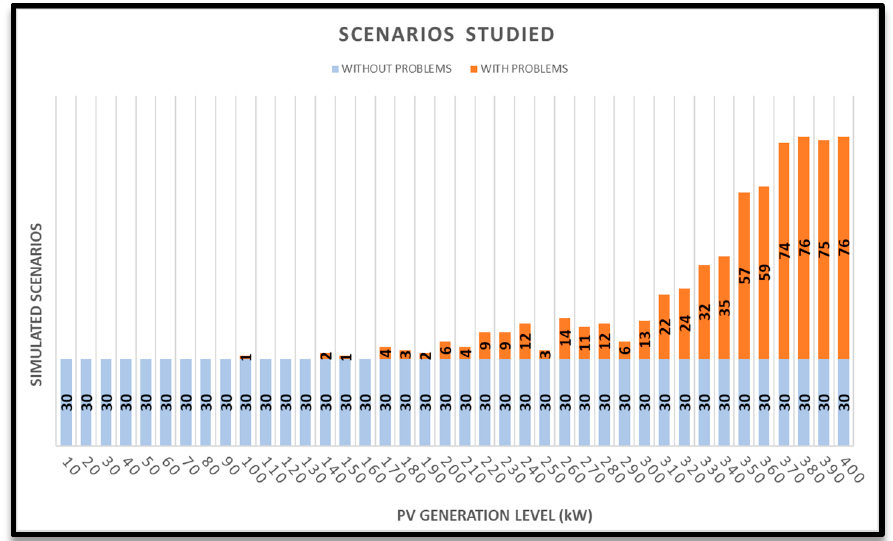
Figure 5. Comparison of simulated scenarios with and without problems.